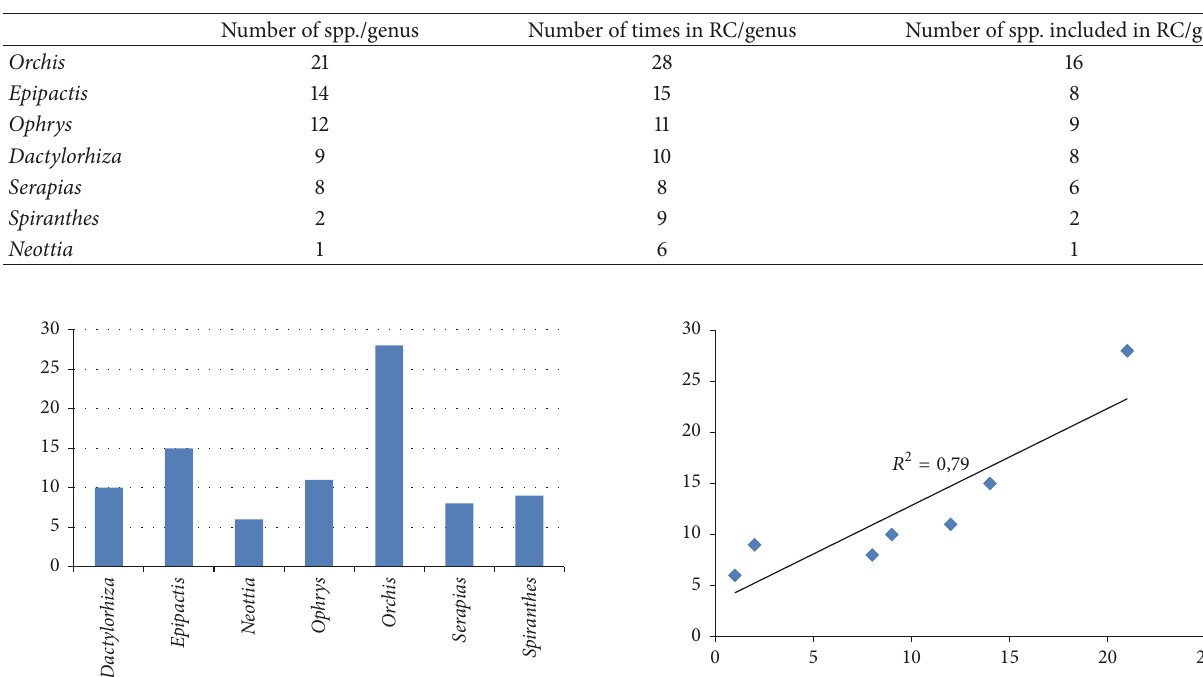
Table 21: Number of species by genus in Spain [76], number of times that they are included in regional catalogues (RC) by genus, and number of species included in regional catalogues (RC) by genus.